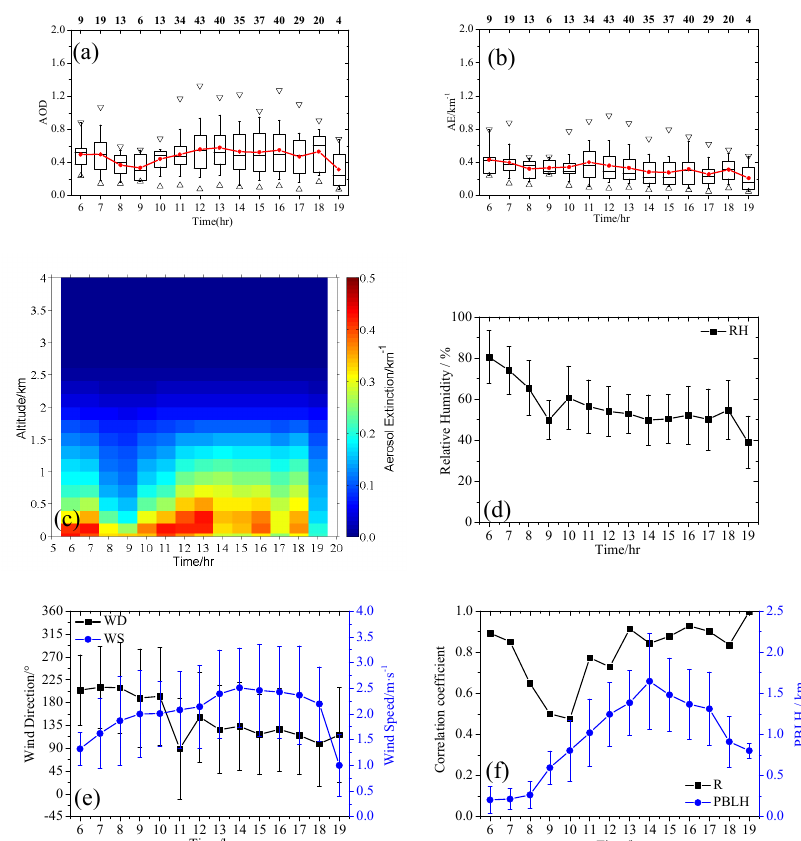
Figure 6. Diurnal variations of ( a ) AOD, ( b ) near-surface AE and ( c ) AE vertical profile based on the qualified hourly MAX-DOAS data, as well as ( d ) relative humidity (RH), ( e ) wind direction (WD) and wind speed (WS) from corresponding in-situ surface observations, ( f ) planetary boundary layer height (PBLH) and the correlation coefficients (R) between AOD and near-surface AE for each h. Lower (upper) error bars, boxes and lower (upper) triangles in Figure 6a,b are the 10th (90th), 25th (75th) percentiles, minima (maxima) of the data grouped in each h, respectively. Hyphens inside the boxes and curves with circles in Figure 6a,b separately denote the medians and the mean values. The numbers of integrated sampling days for specific h are labeled at the top axis in Figure 6a,b. The error bars in Figure 6d–f denote standard deviations of RH, WD, WS, and PBLH for each h, respectively. Note that the PBLH is from linearly interpolated reanalysis data with time interval of 3 h (https://www.ecmwf.int/en/forecasts/datasets/reanalysis-datasets/era5).